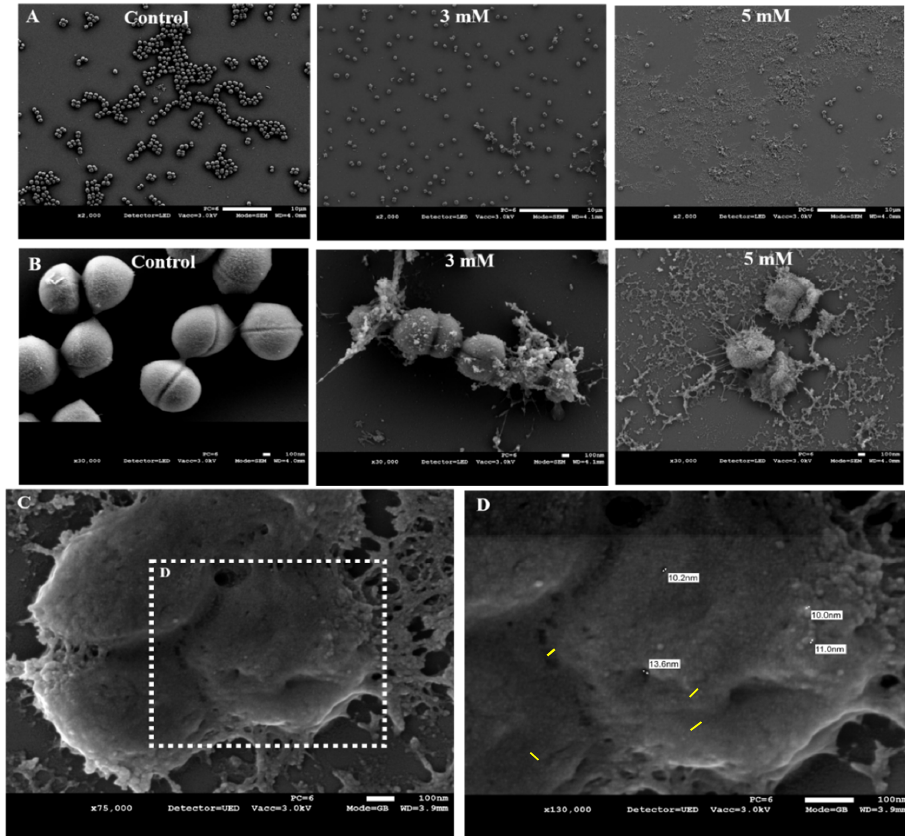
Figure 3. Zn 2+ ions cause lysis of S. epidermidis cells . SEM images of S. epidermidis cells following overnight exposure to ZnCl 2 . Images shown were taken at magnifications of 2000× ( A ), 30,000× ( B ) with a Jeol JSM-IT-100 LV at 5.0–10.0 kV. Magnification at 75,000× ( C ) and 130,000× ( D ) of cells grown with 5 mM of ZnCl 2 . Yellow lines indicate size of cavities (left) and approximate size of leaked content (right).